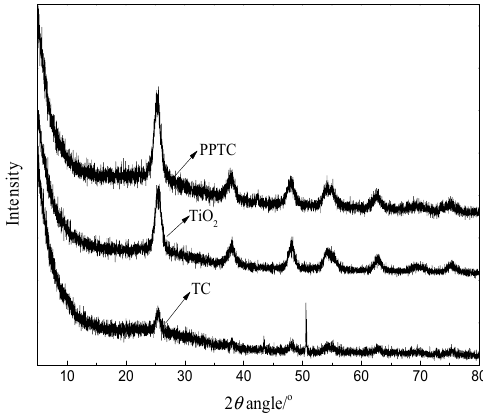
Figure 4. XRD patterns of TiO 2 , TC, and PPTC.